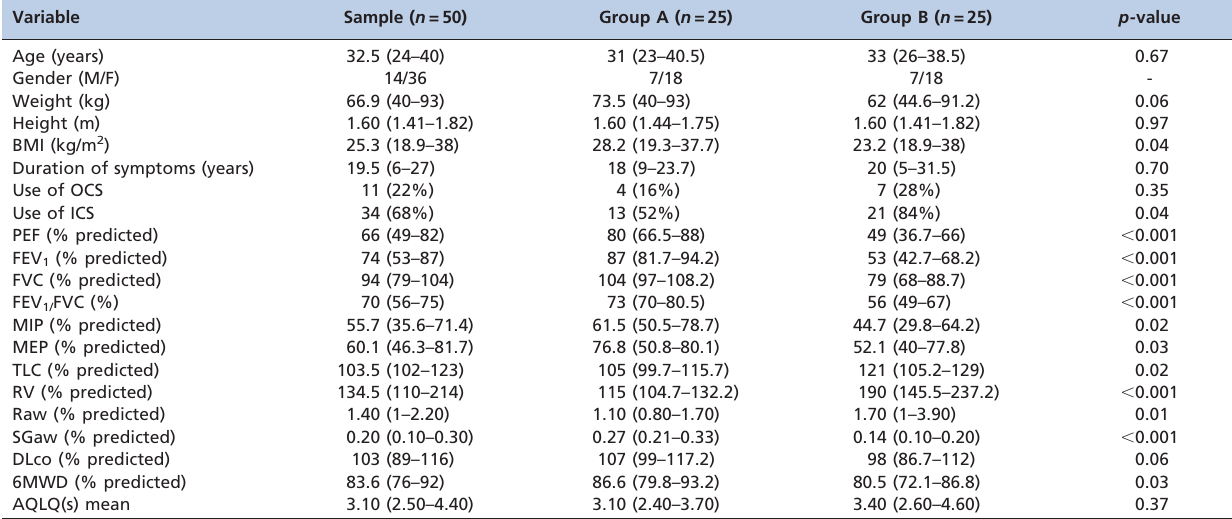
Table 1 - General characteristics, pulmonary function, functional capacity, and QOL of the studied sample. Variable Sample ( n =50)